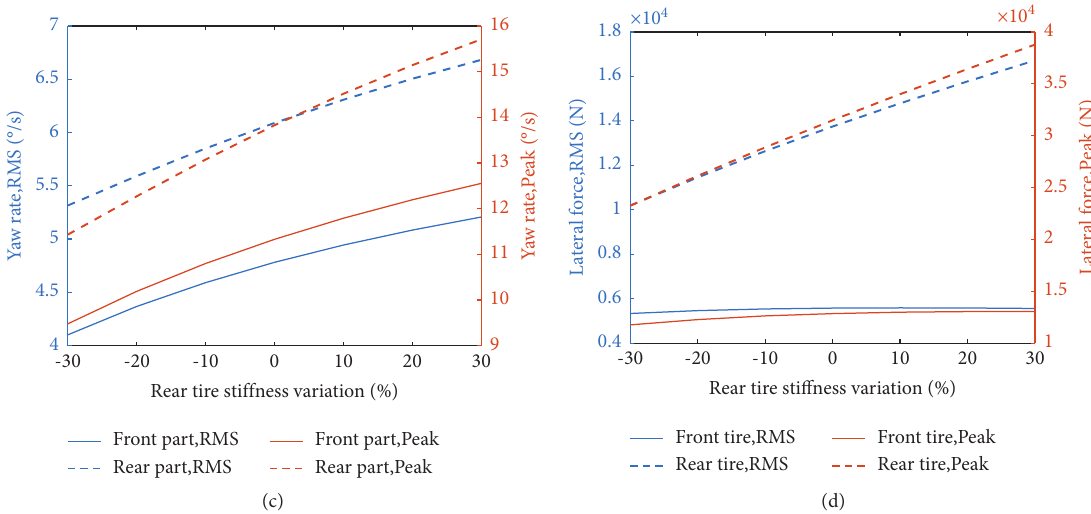
Figure 7: Vehicle performance of the rear tire cornering stiffness variation. (a) RMS and peak value of tire sideslip angle. (b) RMS and peak value of vehicle sideslip angle. (c) RMS and peak vehicle yaw rate. (d) RMS and peak value of lateral force.